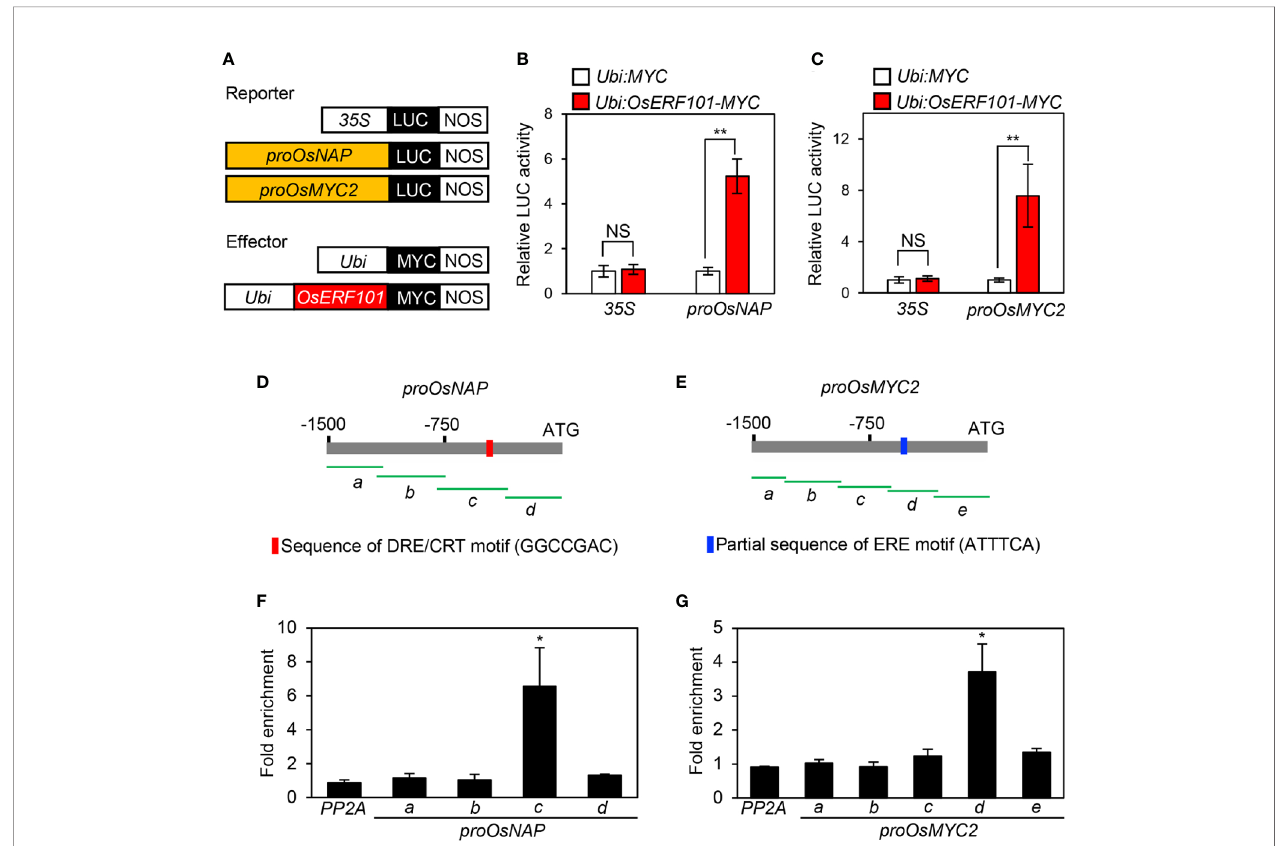
FIGURE 5 | OsERF101 directly activates the transcription of OsNAP and OsMYC2 . (A) Reporter and effector constructs used in the transactivation assay. (B, C) The activation of the OsNAP and OsMYC2 promoter ( proOsNAP and proOsMYC2 ) by OsERF101-MYC in the protoplast transient assay. The 35S promoter was used as a negative control. (D, E) Positions of fragments used for the ChIP assay (green horizontal lines) in the promoter regions of OsNAP and OsMYC2 . Red and blue bars indicate the position of the DRE/CRT and partial ERE binding motifs, respectively. (F, G) OsERF101 binding af fi nity assays to the promoter regions of OsNAP and OsMYC2 in planta examined by ChIP assays. OsERF101-Myc was transiently expressed in protoplasts isolated from 10-day-old WT seedlings. Fold- enrichment of the promoter fragments was measured by immunoprecipitation with an anti-Myc antibody (see Methods ). The SERINE/THREONINE PROTEIN PHOSPHATASE 2A ( PP2A ) gene was used as a negative control. Mean and standard deviations were obtained from more than fi ve biological repeats. Asterisks indicate a signi fi cant difference compared with the negative control (Student ’ s t -test, * p < 0.05, ** p <